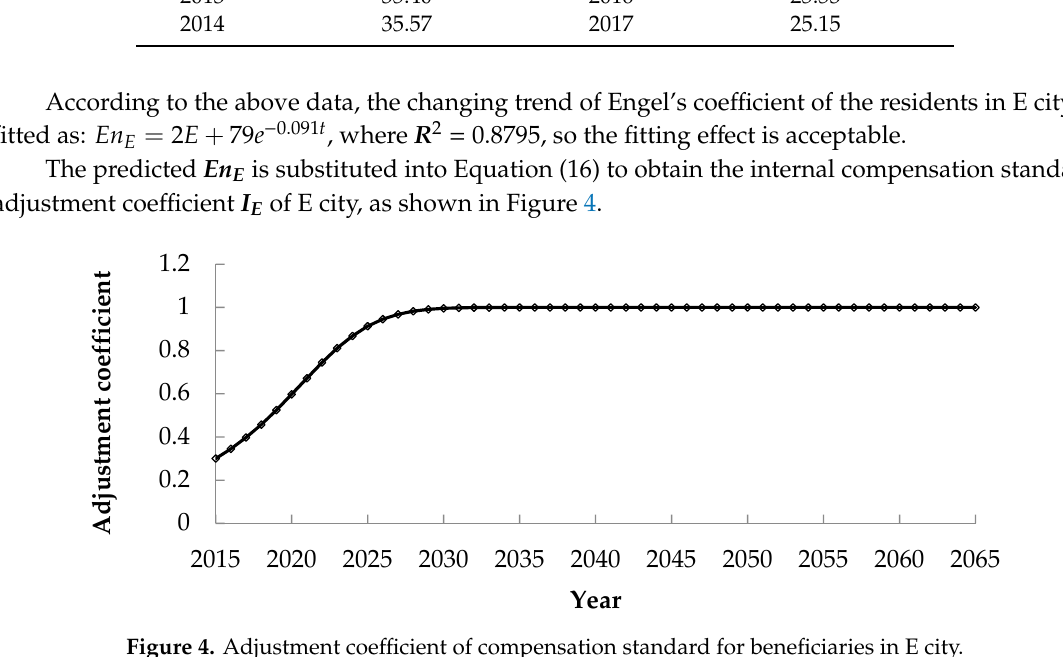
Figure 4. Adjustment coe ffi cient of compensation standard for beneficiaries in E city.